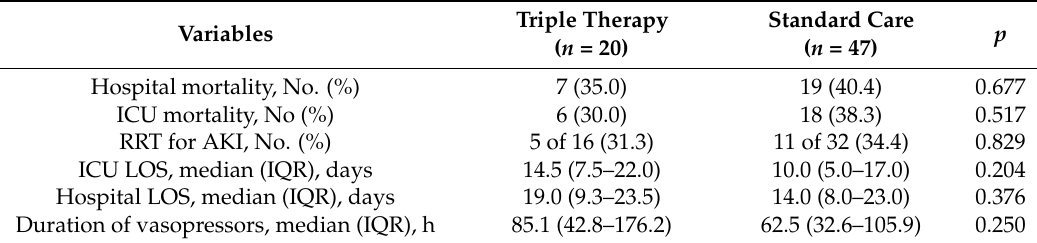
Table 3. Subgroup analysis of patients who completed triple therapy (full four days or transferred out of the intensive care unit (ICU)) versus no triple